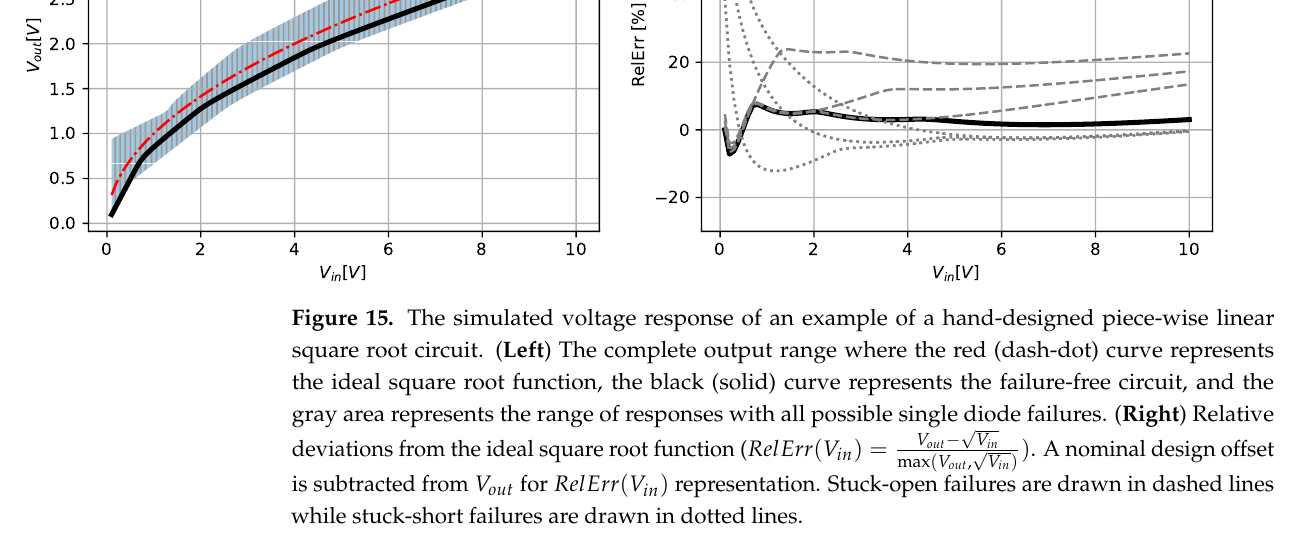
√ V in ) . A nominal design offset √ V in ) max ( V out ,